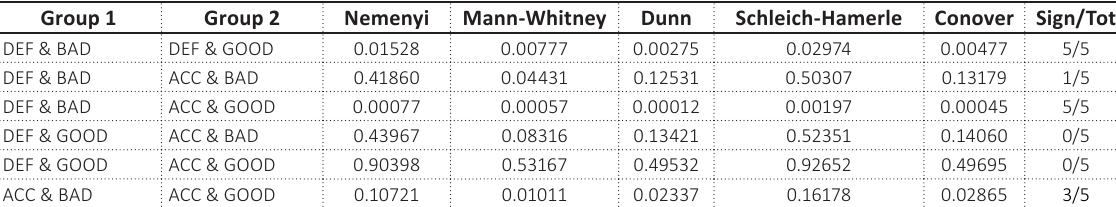
Table 6. Comparison between group